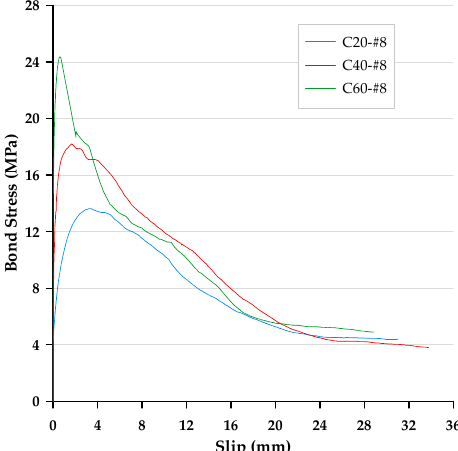
Figure 8. Local bond stress–slip curve for specimens with the #8 rebar.